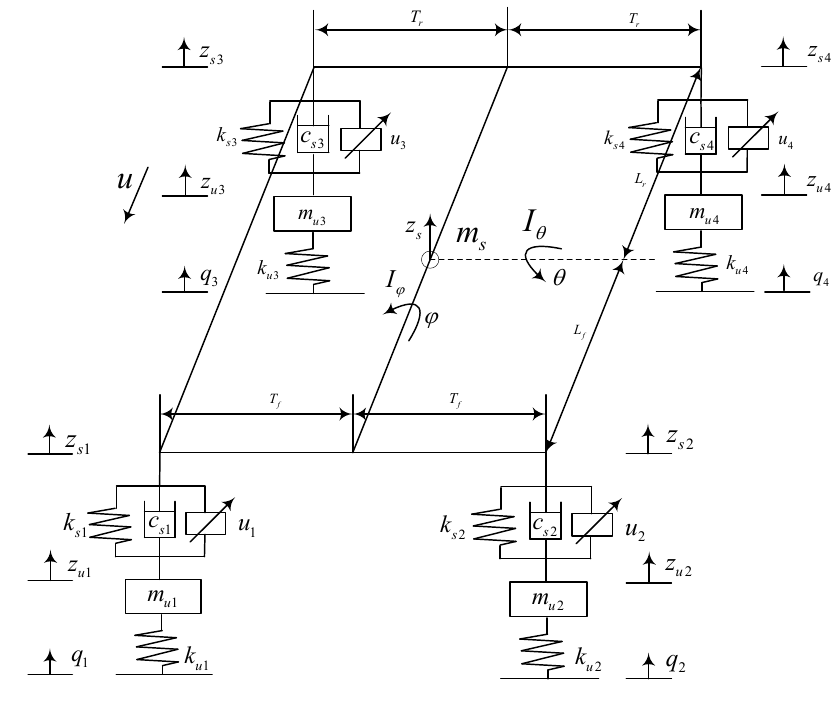
Figure 2. Seven - DOF Model of the Full Vehicle. Figure 2. Seven -DOF Model of the Full m represents the sprung The meanings of the symbols in Figure 2 are as follows: s z represents the vertical displacement at the body centroid, ϕ mass of the suspension, s represents the vehicle roll angle, I ϕ represents the moment of inertia for mass roll angle on the spring of suspension, θ represents the vehicle pitch angle, I θ represents the , , , q q q q repre- moment of inertia for mass pitch angle on the spring of suspension, 1 2 3 4 sent road excitation for wheels, z represent the vertical vibration displace- z z represent the vertical vibration displacement , , ment of the unsprung mass, s 1 , , , u u u u represent the actuation force for the actuator, of the sprung mass, 1 2 3 4 c represent the damping coefficient of the suspension damper , , k represent the suspension spring stiffness, represent the tire elasticity 1 coefficient, m represent the unsprung mass, f L represents the distance L represents the distance from the from the mass center on the spring to the front axle, r mass center on the spring to the rear axle, f T represents the distance from the sprung T represents the distance from the sprung mass center mass center to the front wheel, r to the rear wheel . The seven degrees of freedom are , , z z z θϕ . When the pitch angle and roll angle are small, the dynamic differential equation of the seven degrees of freedom vehicle model is as follows: Vertical displacements at the four endpoints of the body: 1